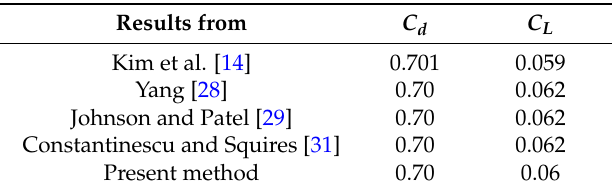
Table 2. Force coefficients for flow past over a sphere at Re = 250.